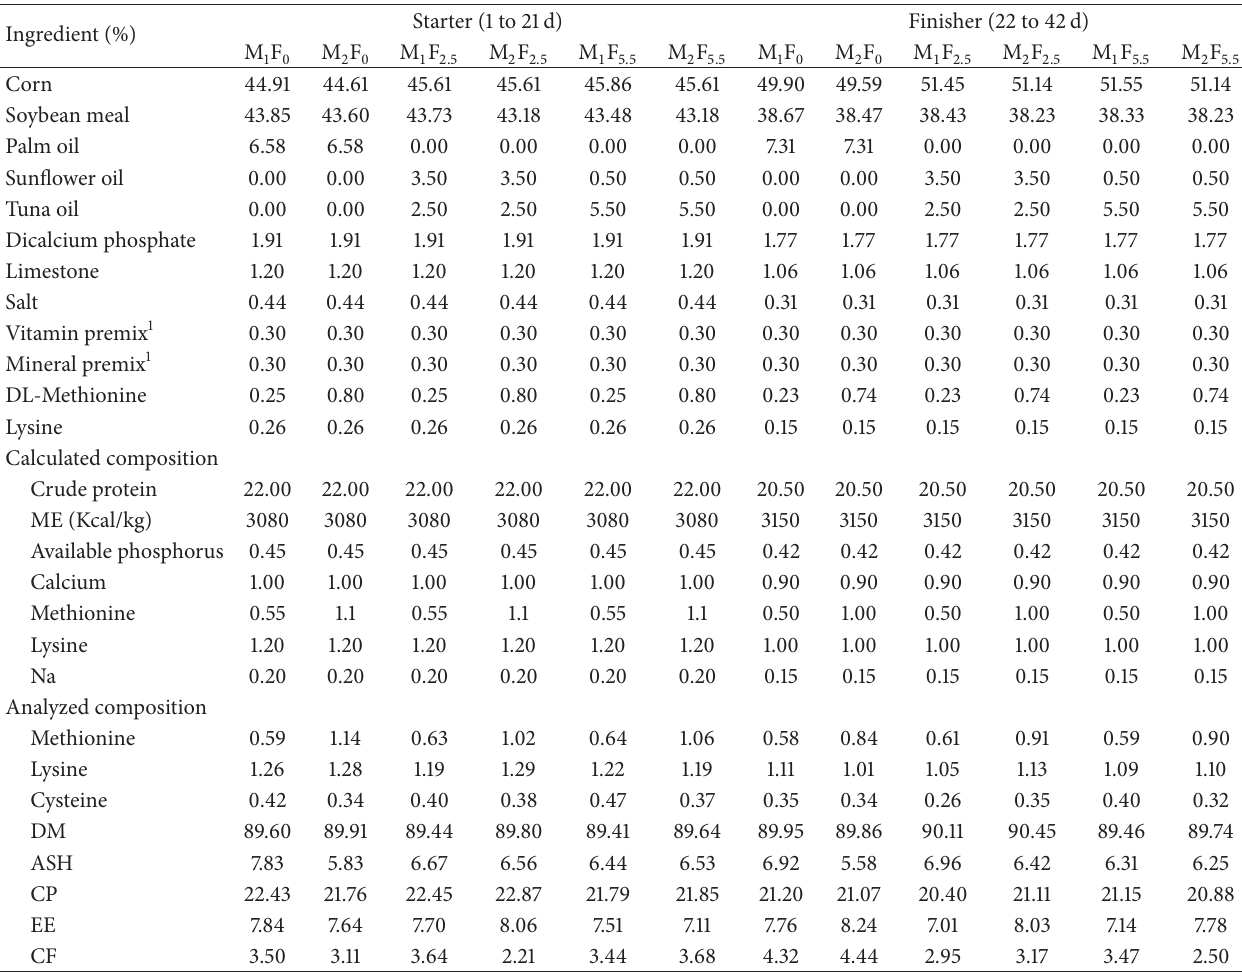
Table 1: Ingredients and nutrients composition of experimental